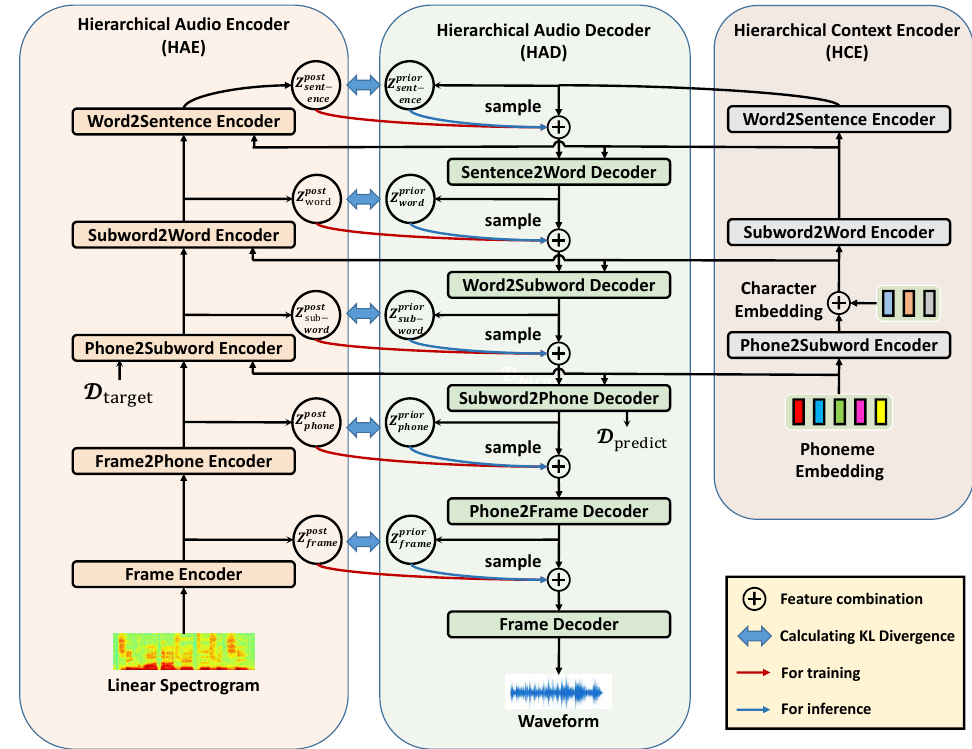
Figure 1. The architecture of